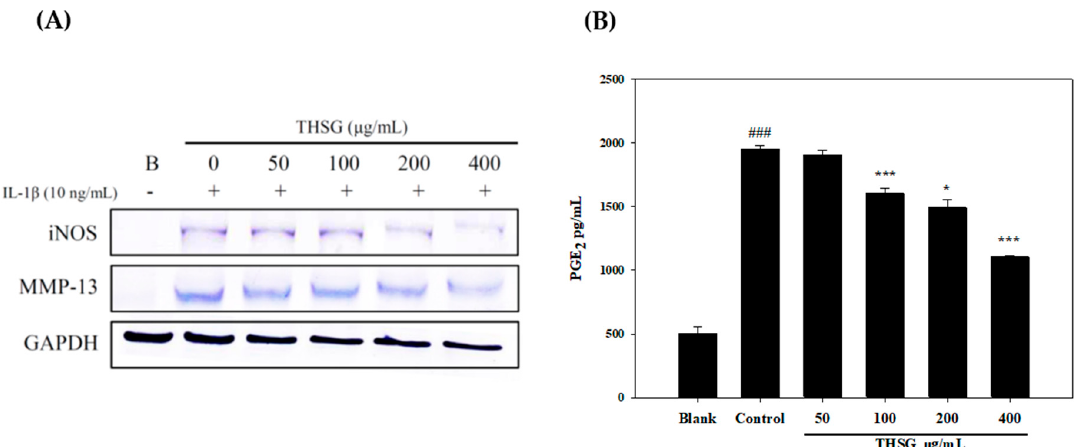
Figure 5. Effects of 2,3,5,4 ′ -Tetrahydroxy-stilbene-2- O - β - D -glucoside THSG inhibited iNOS and MMP-13 expression on IL- β induced primary rat chondrocytes ( A ); PGE 2 production level ( B ), #: control group compared to blank group, ### p < 0.005; *: THSG group compared to control group, * p < 0.05, *** p < 0.005.